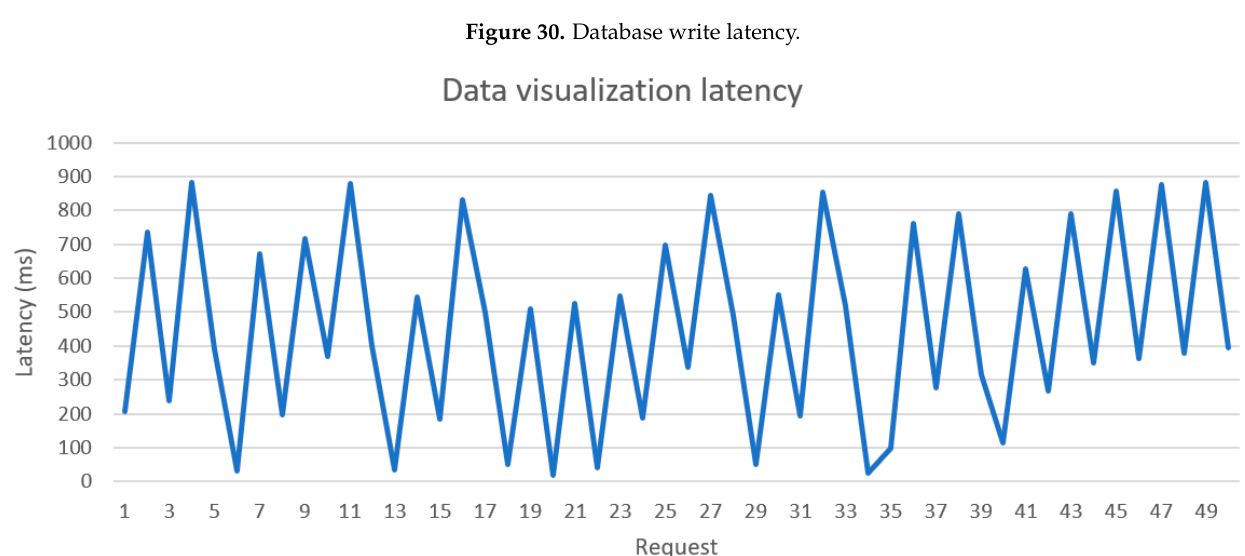
Figure 31. Database visualization latency.